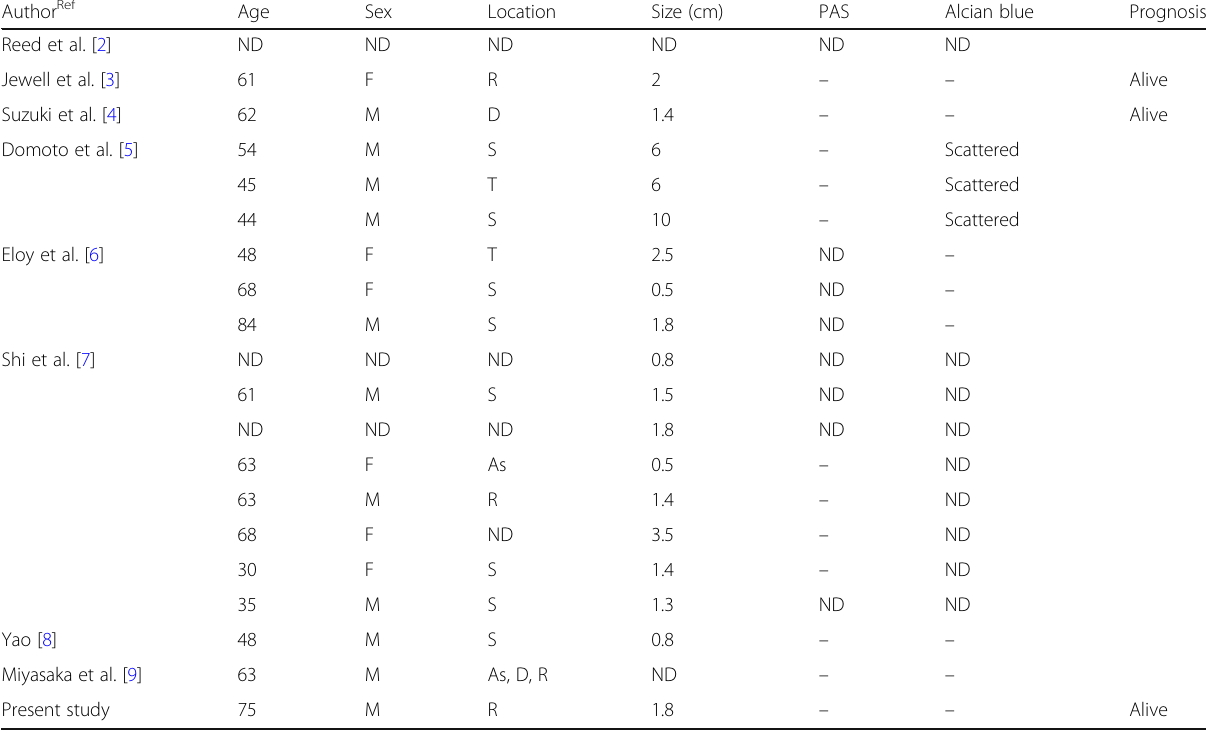
Table 2 Clinicopathological information for 20 colorectal adenomas with clear cell components Author